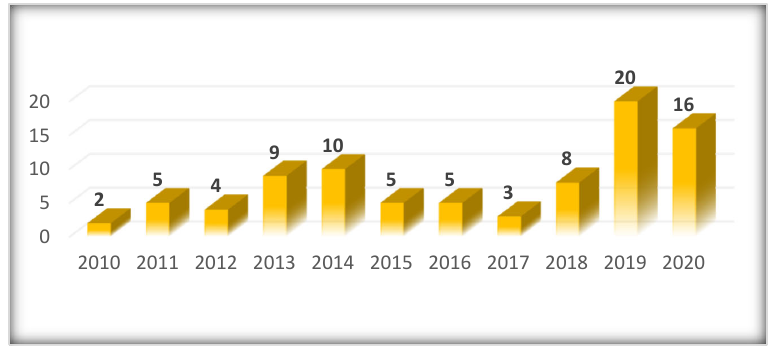
Fig. 18. Numbers of hybrid metaheuristics according to